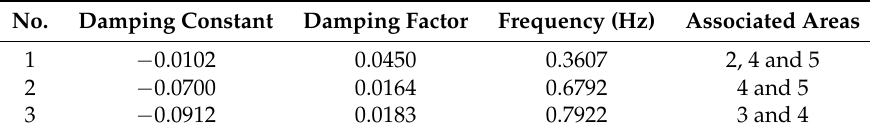
Table 1. Results of deterministic eigenvalue analysis without